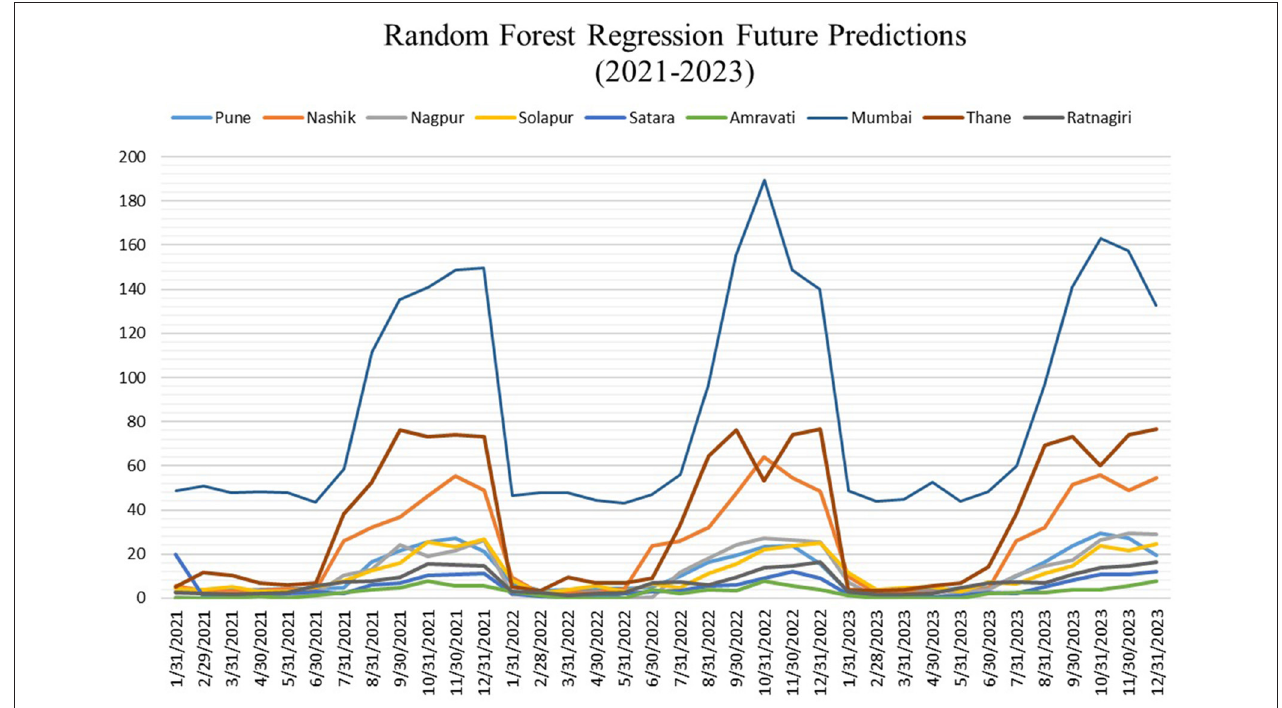
FIGURE 7 | Predictions for random forest regression model (X-axis: Date and Y-axis: Dengue